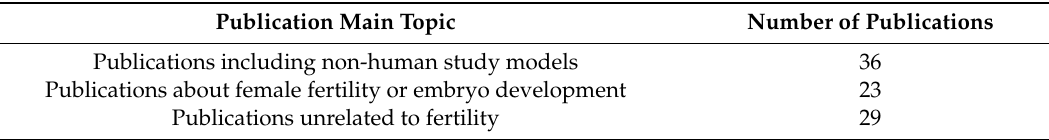
Table 3. Number of publications that meet the exclusion criteria because of its main topic.